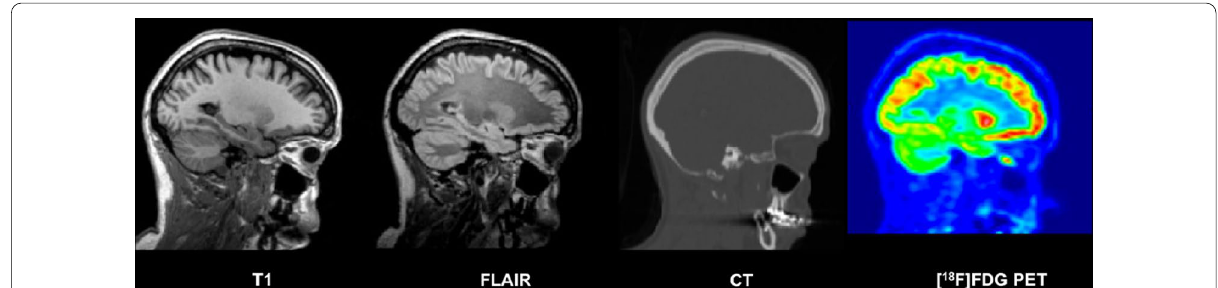
Fig. 1 Example of coregistered T1 MRI, FLAIR MRI, CT and [ 18 F]FDG PET images (sagittal plane) for one subject of the database